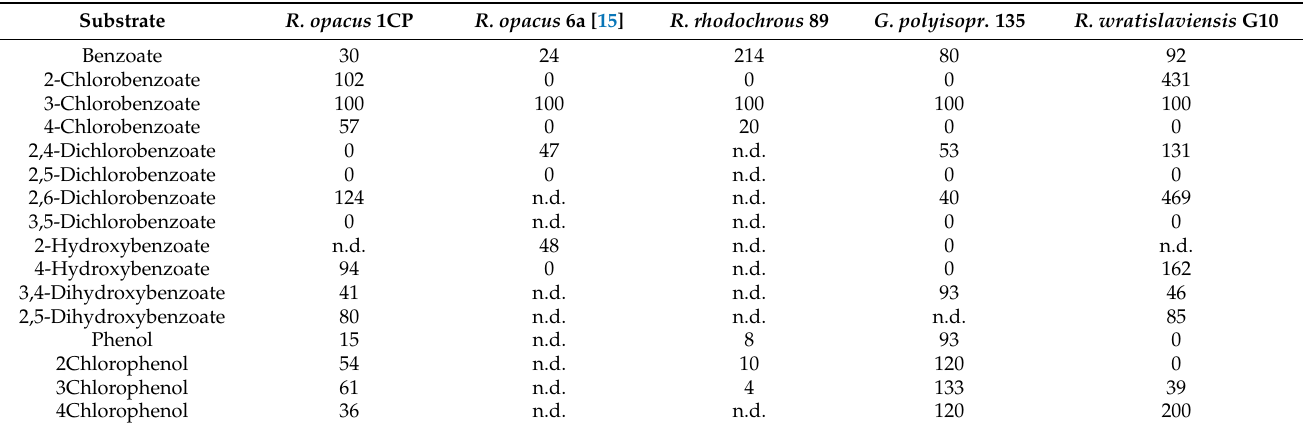
Table 1. Substrate specificity of 3CBDO of actinobacterial cultures grown in the presence of 3CBA, %.